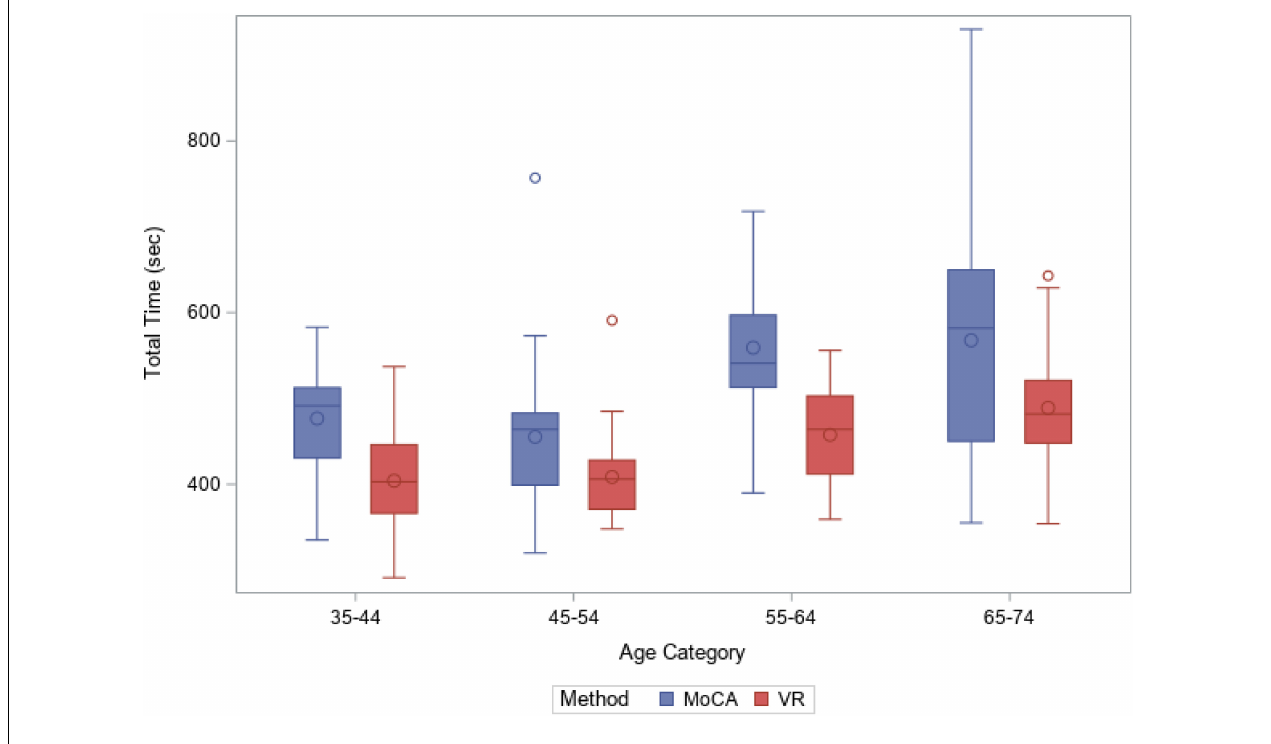
FIGURE 4 | Total time taken (sec), MoCA vs. Virtual Reality (CAVIRE), by age groups.